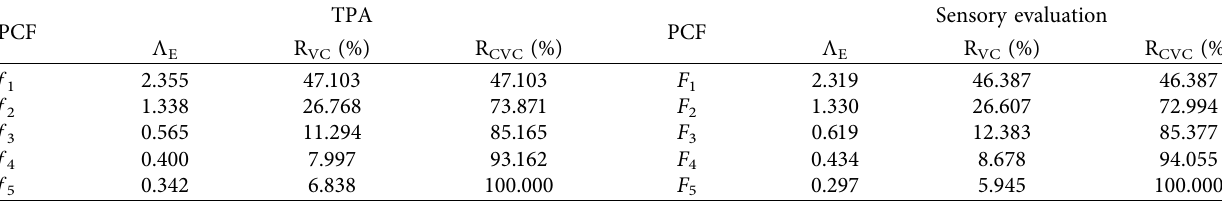
Table 4: Total variance for the TPA and sensory